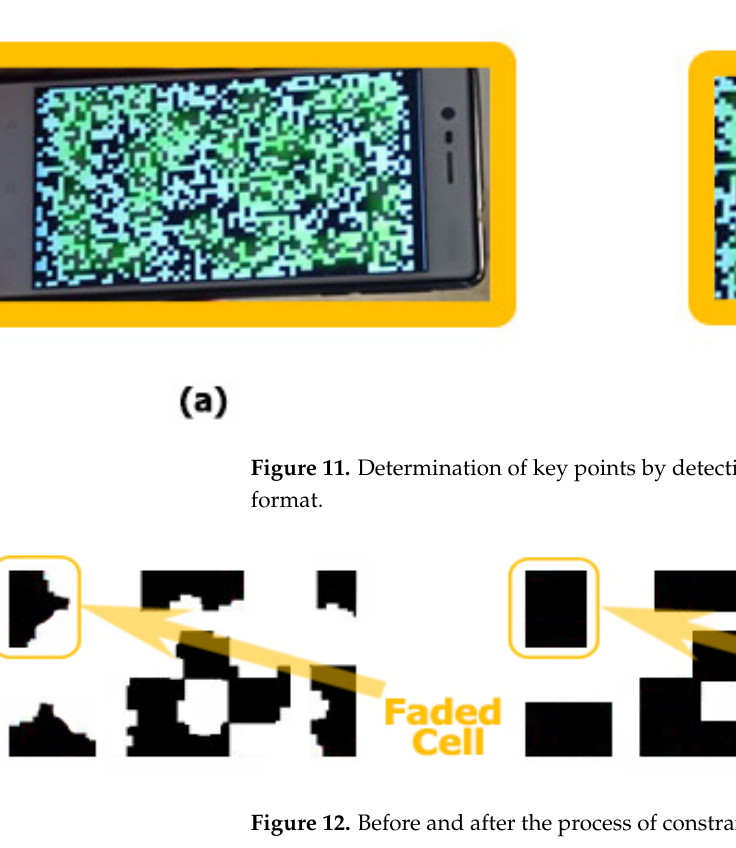
Figure 12. Before and after the process of constraining a data set (quantization).